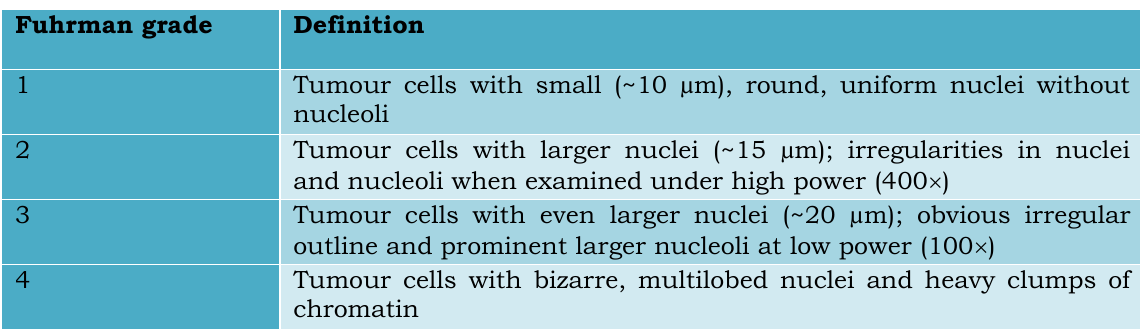
Table 1. Fuhrman histological grade for RCC